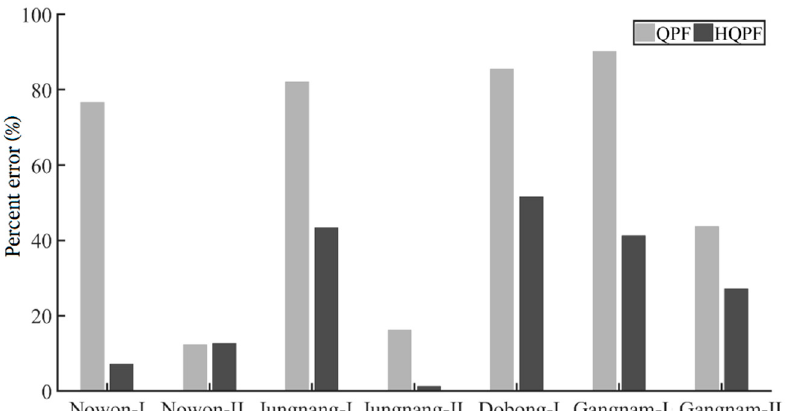
Figure 10. Comparison of the percentage errors in Table 5.